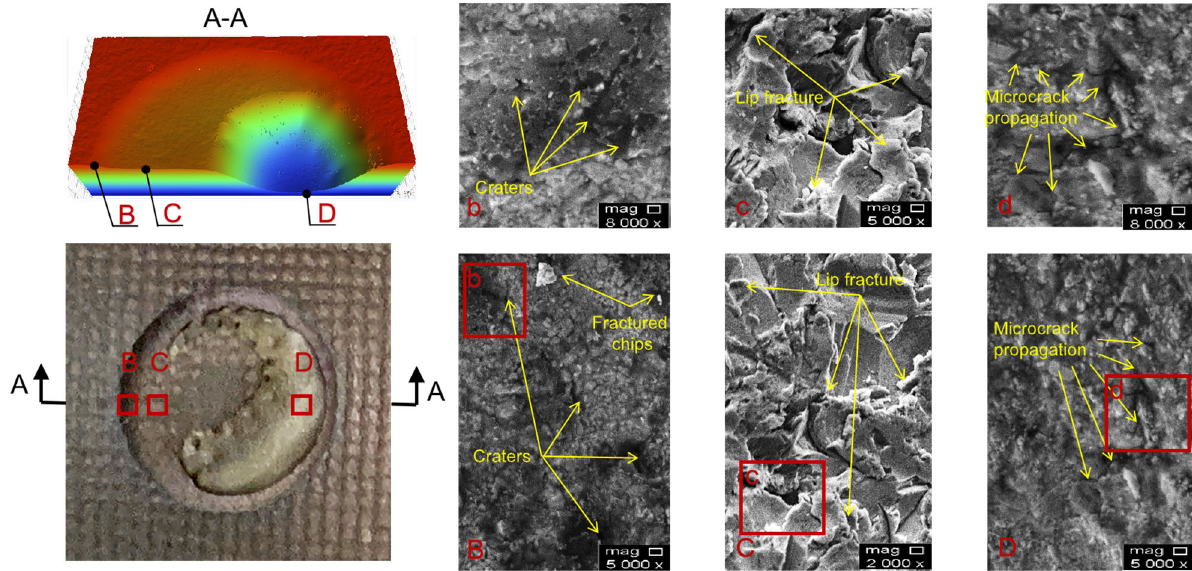
Figure 10. Erosion morphology of textured coating ( B , b SEM micro ‐ graph of point B in A ‐ A diagram, C , c SEM micro ‐ graph of point C in A ‐ A diagram, D , d SEM micro ‐ graph of point D in A ‐ A diagram).